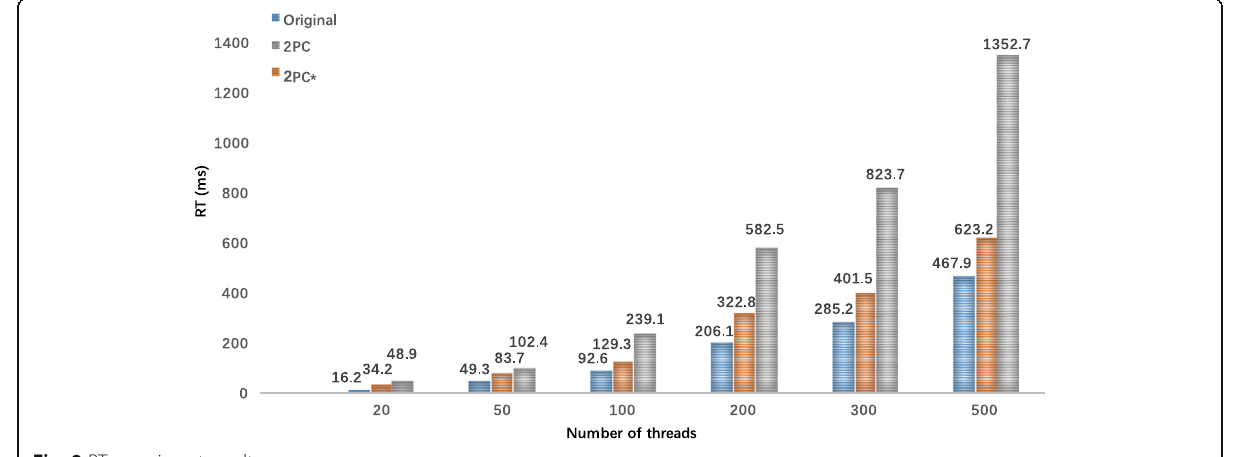
Fig. 9 RT experiment